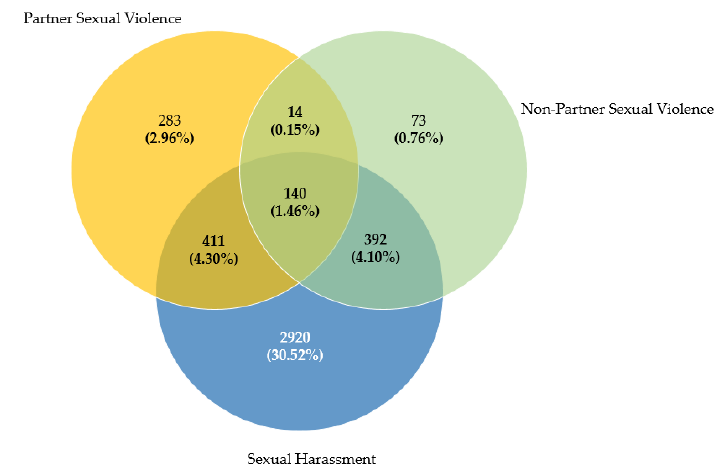
Figure 1. Frequency and relationships between the three forms of sexual violence.